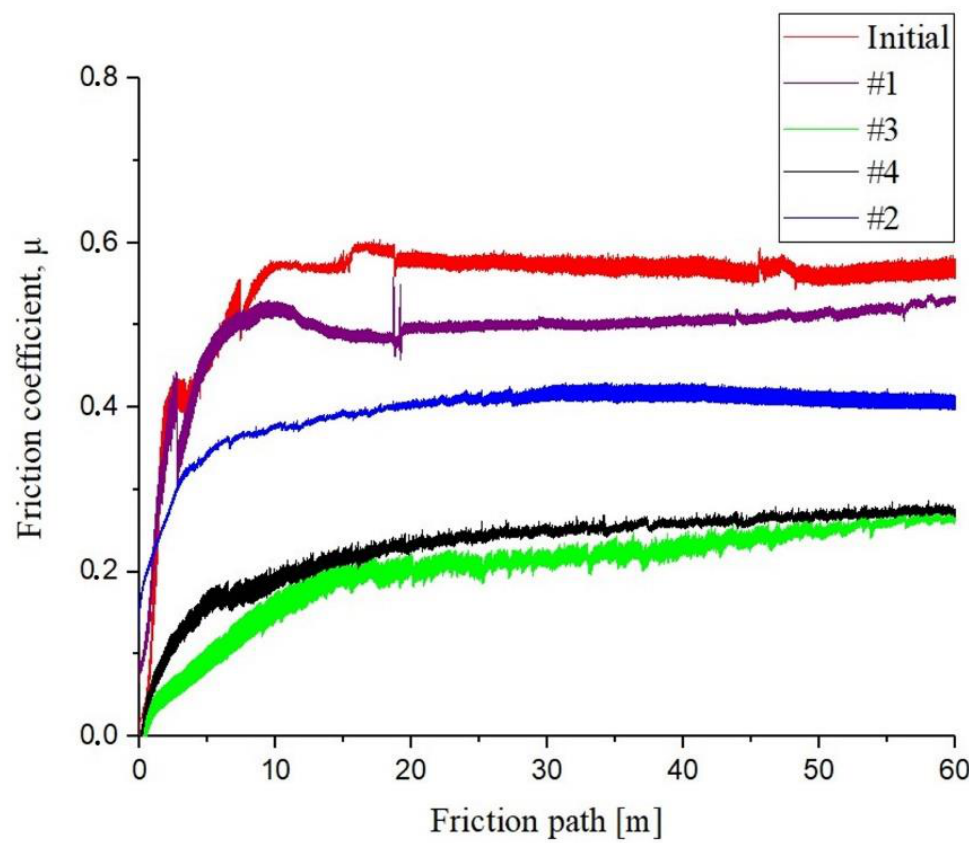
Figure 8. Graph of the dependence of the sliding friction coefficient on the path 30CrMnSiA steel at different modes of thermocyclic hardening.